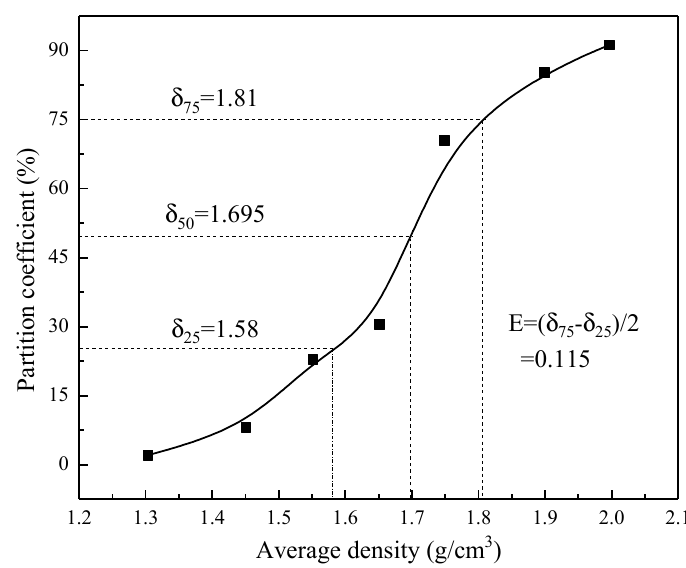
Figure 12. Partition coefficient of the compound dry separation − 6 + 1 mm fine coal.